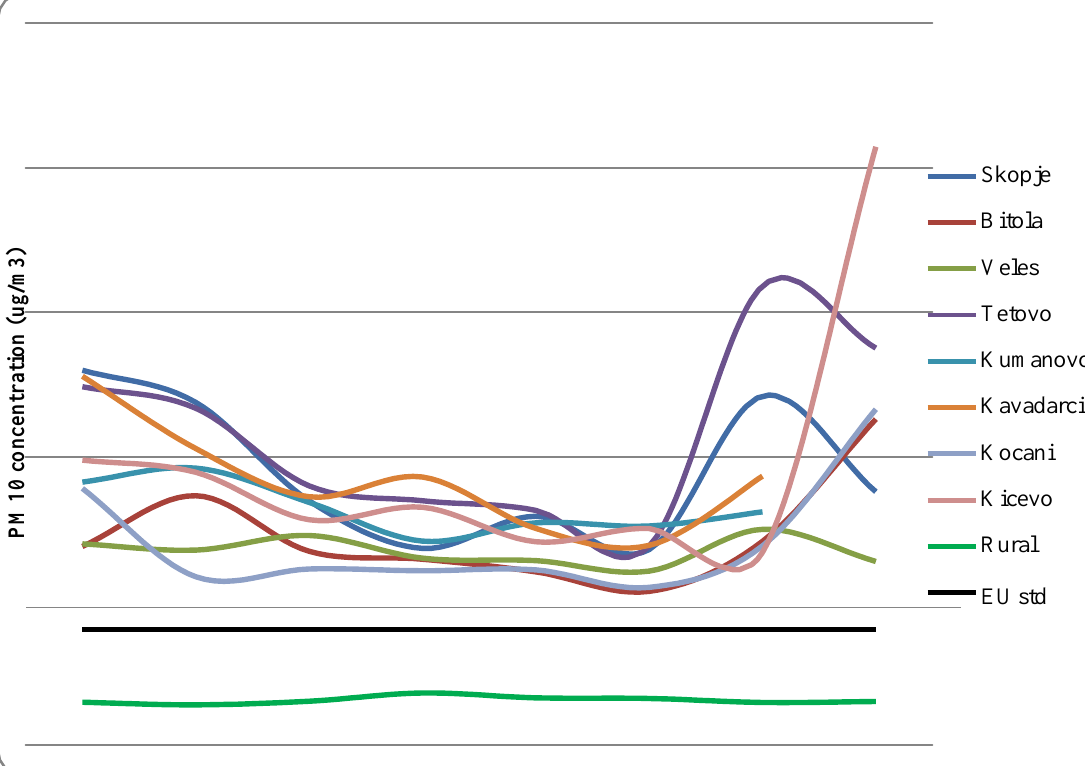
Figure 1. Annual average PM